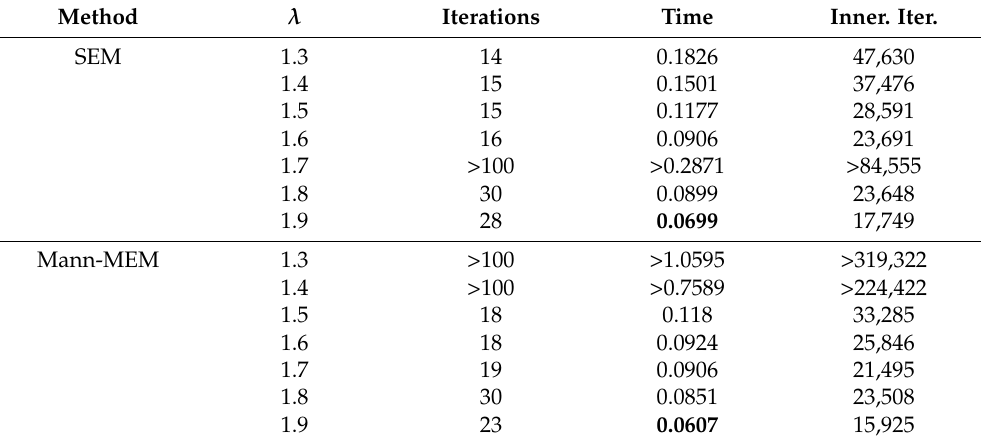
Table 1. Effects of the step size for numerous parameters λ > 0, with execution sub-gradient extra- gradient and Mann mean extra-gradient